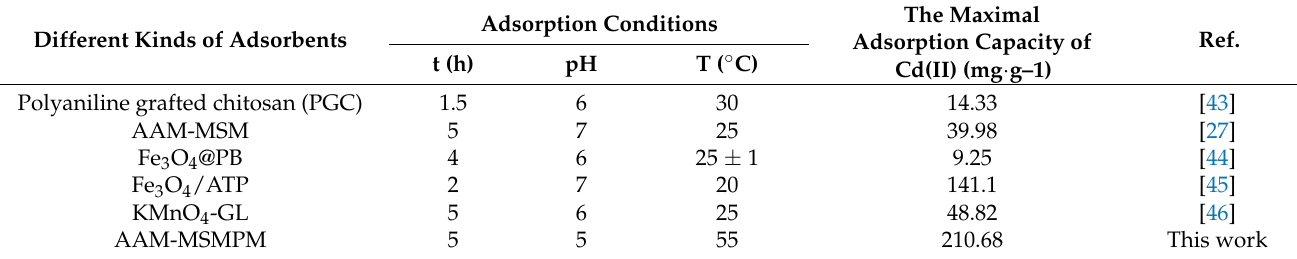
Table 5. Comparison of adsorption capacities for Cd(II) on the AAM-MSMPM with other adsorbents.